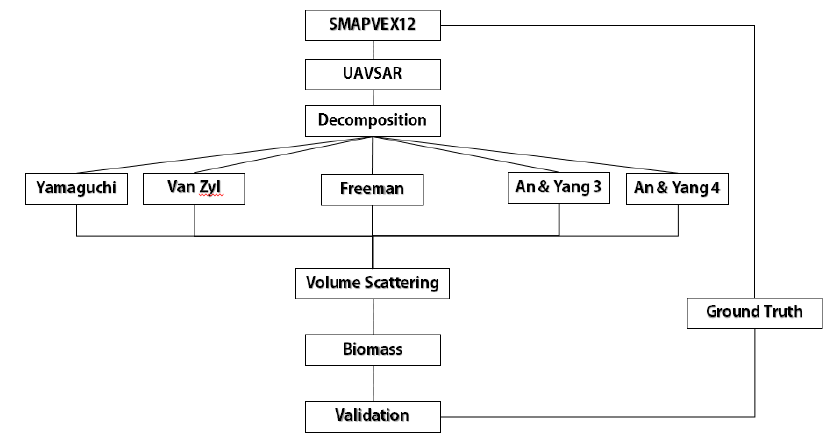
Figure. 3. Schematic diagram of biomass over agricultural fields using five polarimetric decomposition methods.